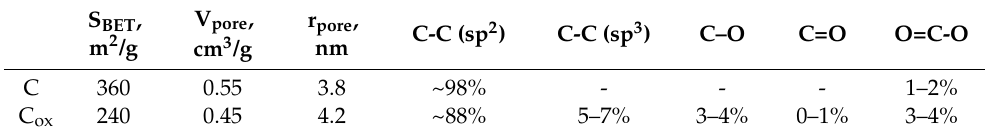
Table 2. Textural characteristics of the carrier and the proportion of carbon atoms in various